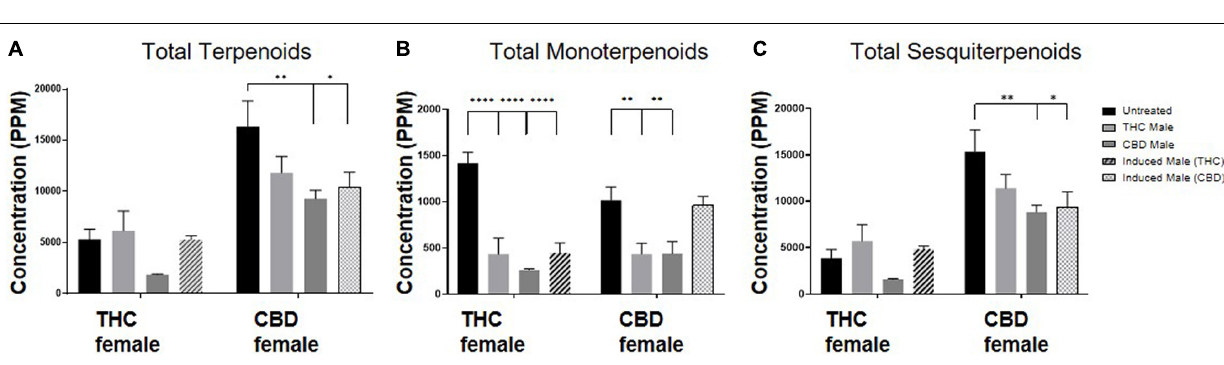
FIGURE 3 | Terpenoid profiles of Cannabis strains before and after fertilization. Overlay of chromatograms of the unfertilized and fertilized samples of (A) THC-rich and (B) CBD-rich female plants were performed by the same scales [retention time (RT); relative abundance of the signal intensity; weight of the samples (10 mg)], showing monoterpenoids on the left and sesquiterpenoids on the right. * Terpenoids that were semi-quantified.